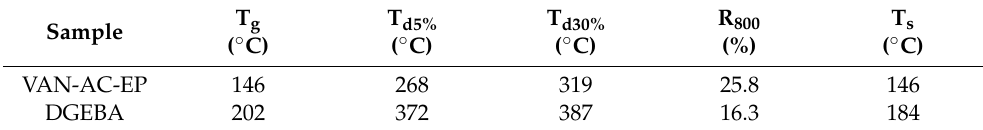
Table 2. Thermal performance of thermosetting